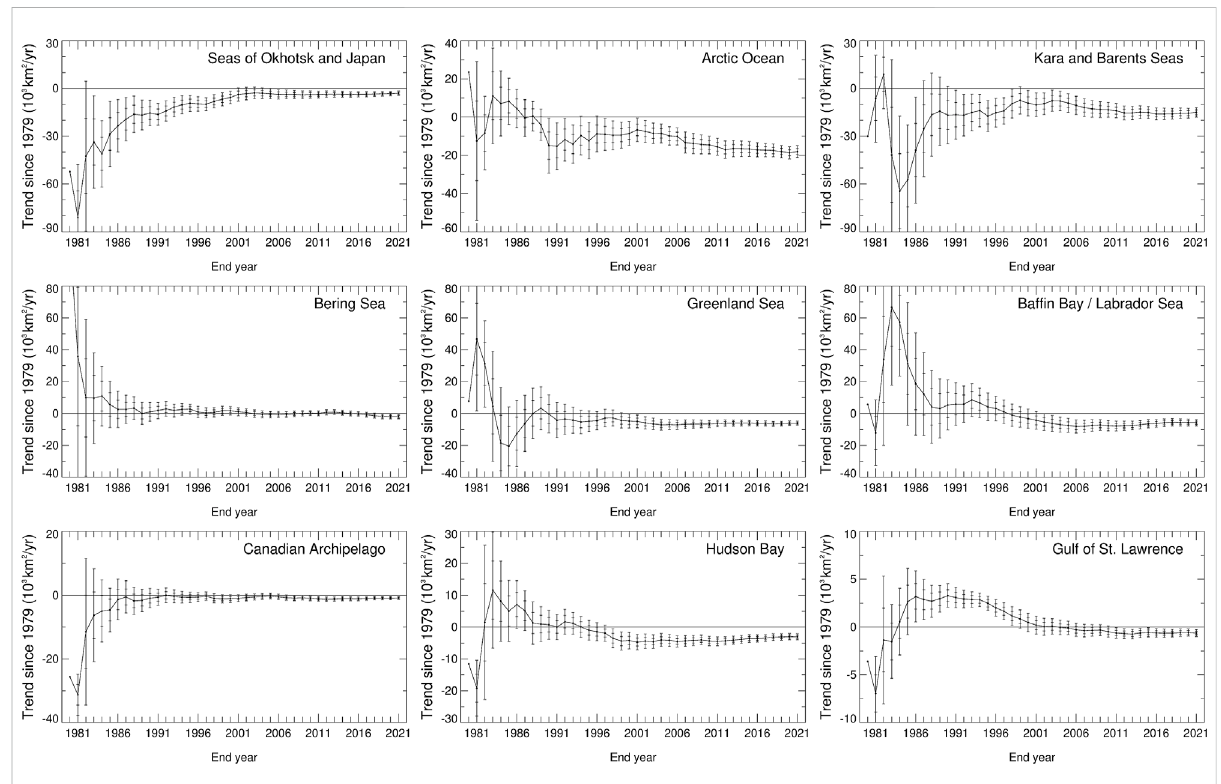
FIGURE 7 Linear-least-square slopes of the trend line in yearly average sea ice extents, from the 1979 – 1980 slope with only 2 years of data to the 1979 – 2021 slope with 43 years of data, for the following regions: Seas of Okhotsk and Japan; Arctic Ocean; Kara and Barents Seas; Bering Sea; Greenland Sea; Baf fi n Bay/Labrador Sea; Canadian Archipelago; Hudson Bay; and Gulf of St. Lawrence. The bars centered on each trend value after the fi rst have ticks marking one and two standard deviations from the